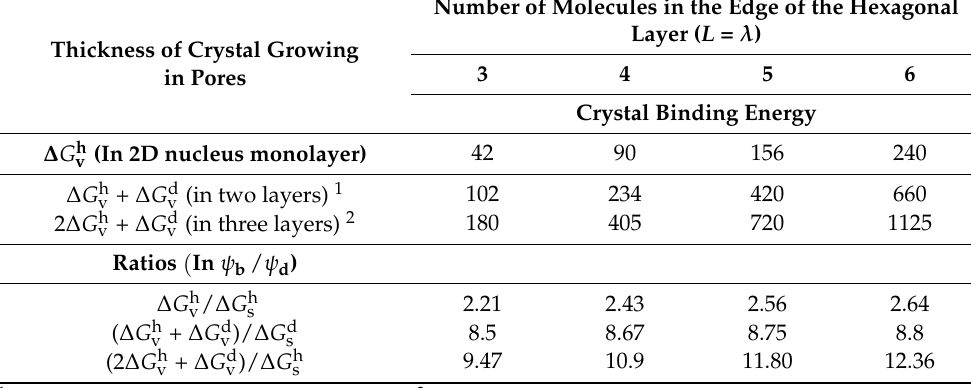
Table 1. Results for HCP crystal calculated by means of Equations (1) to (6). The analysis stops at λ = 6 because the tendency is clear, and the consideration of larger crystals is superfluous. Number of Molecules in the Edge of the Thickness of Crystal Growing in Pores